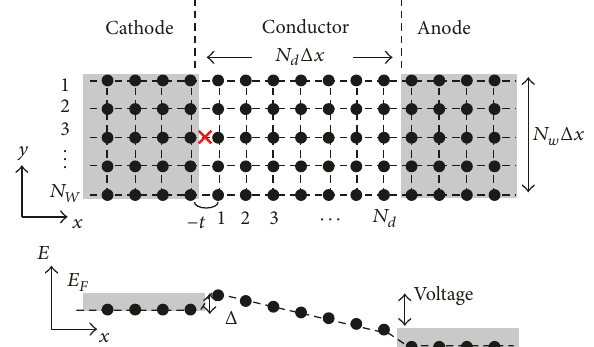
Figure 1: Model of the device studied in this paper. Virtual atoms, denoted by dots, are associated with an s-like orbital, and neighboring orbitals are connected by hopping interaction “ −𝑡. ” The conductor consists of an 𝑁 𝑑 ×𝑁 𝑤 array of the virtual atoms. On both sides of the conductor, there are reservoirs shown by shaded areas. A defect between reservoirs and conductor indicated by cross where the hopping interaction is replaced by a smaller